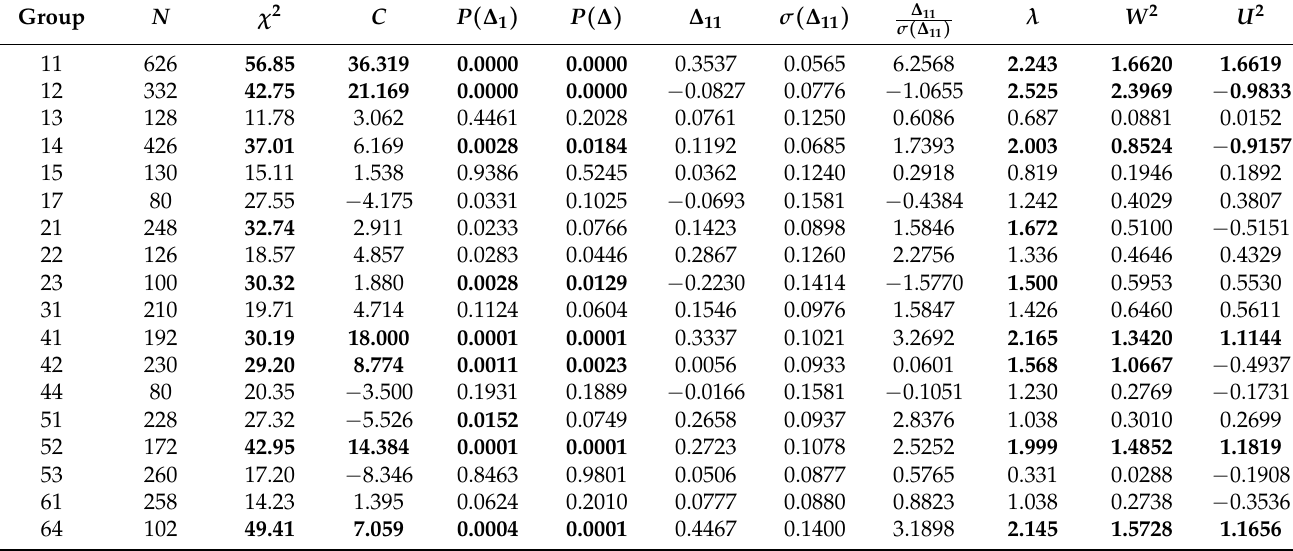
Table 4. Test for isotropy of the orientations of the galaxy plane. The distribution of the angle η of galaxies; inclination was calculated on the basis of the value of the parameter q 0 depending on the morphological types of